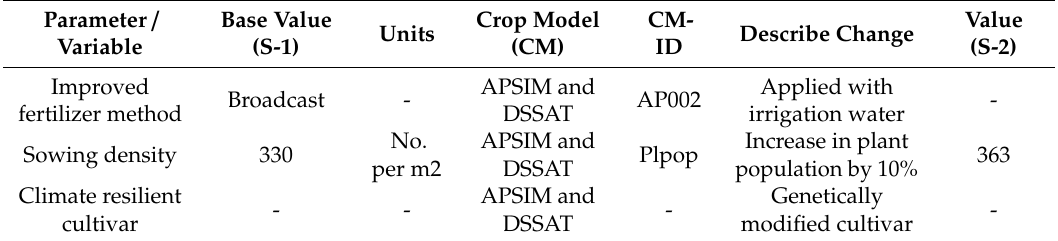
Table 1. Climate change adaptation package used for wheat.